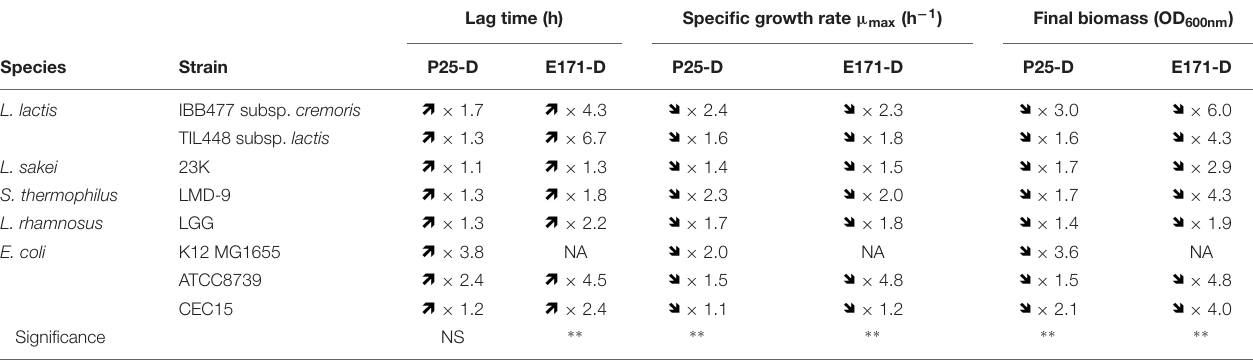
TABLE 2 | Sensitivity of all bacterial strains to Titanium dioxide (TiO 2 ) in its dispersed form (P25-D in light green and E171-D in light